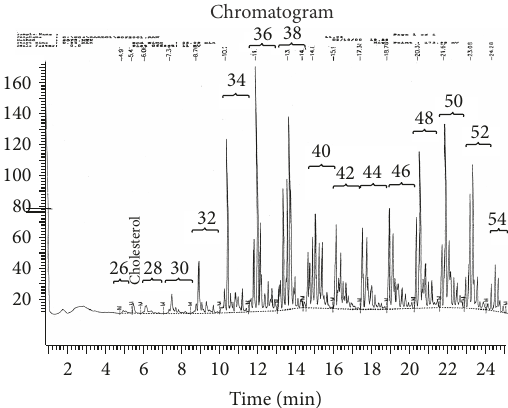
Figure 1: Gas chromatogram showing a typical integration for 15 families of triglycerides from 26 to 54 carbon atoms, excluding the contribution of the glycerol moiety. The cholesterol peak is